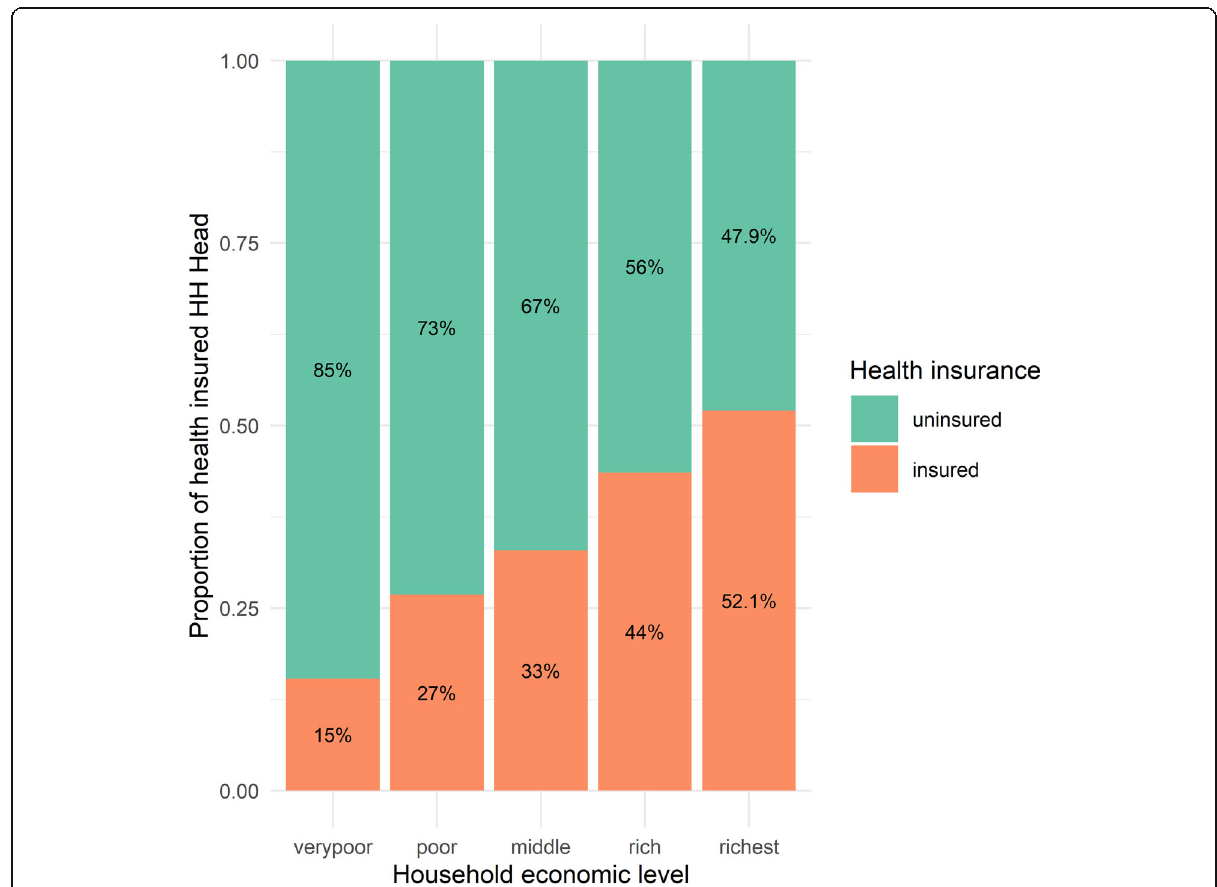
Fig. 3 Distribution of rural households by health insurance coverage of household head across economic